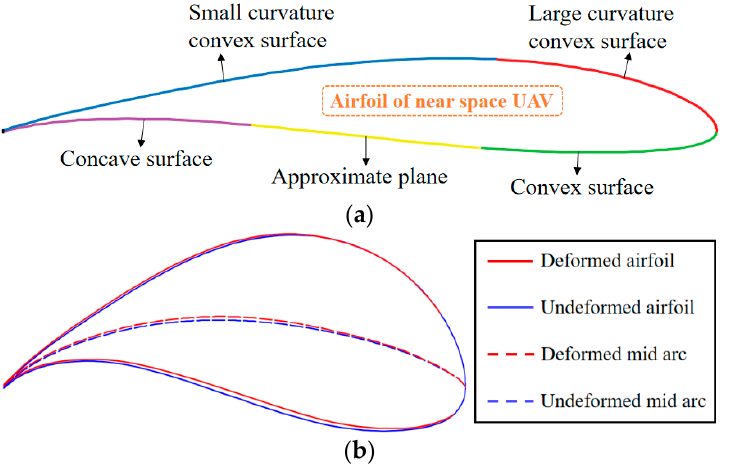
Figure 8. Typical airfoil curve and shape comparison before and after deformation: ( a ) Typical airfoil of near space UAV; ( b ) The airfoil shape before and after deformation.